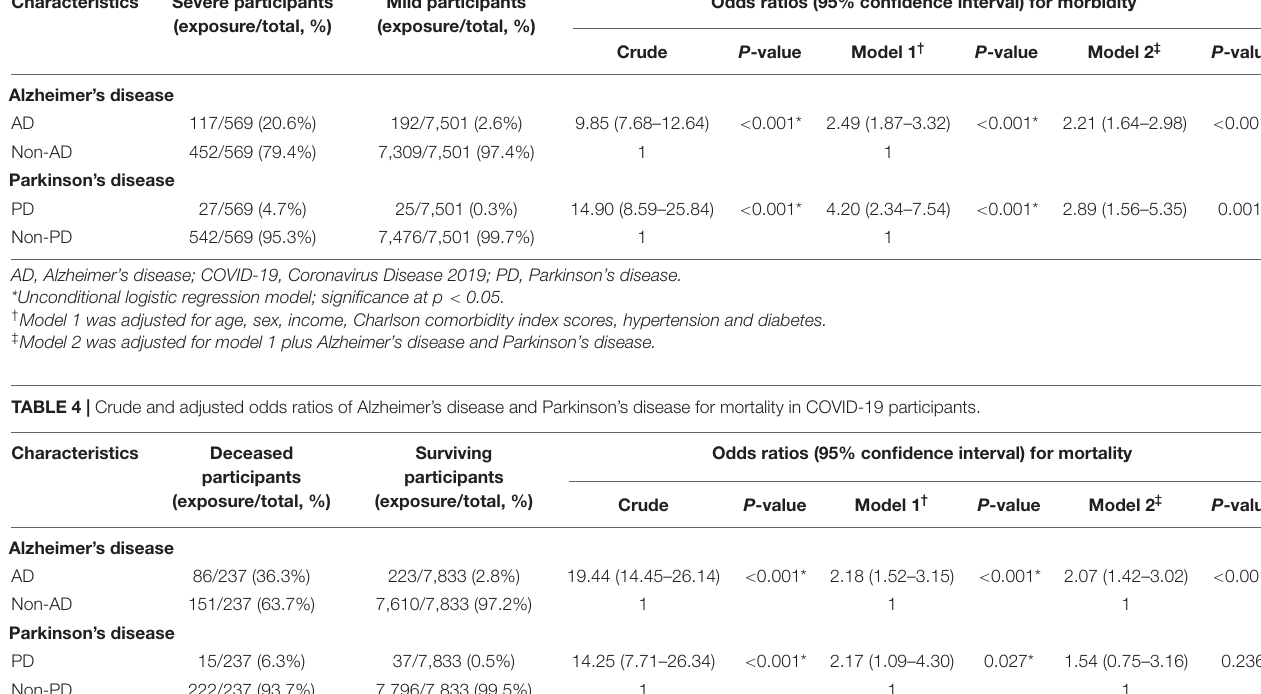
TABLE 3 | Crude and adjusted odds ratios of Alzheimer’s disease and Parkinson’s disease for morbidity in COVID-19 participants. Characteristics